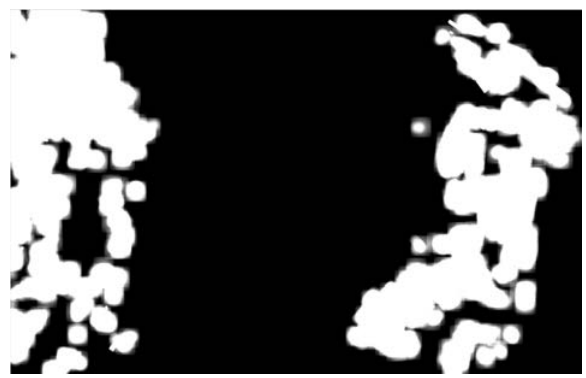
Fig.4 the radiation intensity map of multi geometric features According to the method described in Section 2.4, the original image was down sampled to three scales (1m ， 2m ， 4m). Then the visual saliency features such as edge features (Fig.5-(a)), orthogonal saliency features (Fig.5-(b)), local brightness (Fig.5- (c)) and local contrast (Fig.5-(d)) were extracted and fused into a visual saliency image in each scale (Fig.5-(e) and (Fig.5-(f))). Finally, we got the final visual saliency image of the artificial areas by fusing all visual saliency images which is shown